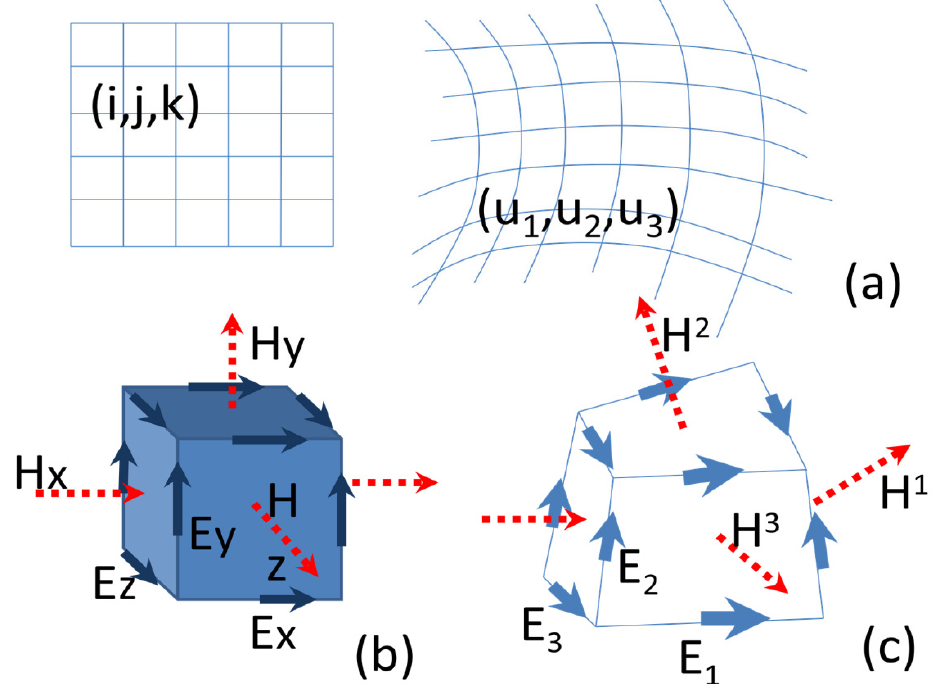
Figure 1. ( a ) Curvilinear mesh. ( b ) FDTD orthogonal cell. ( c ) Covariant and contravariant fields in curvilinear cell.